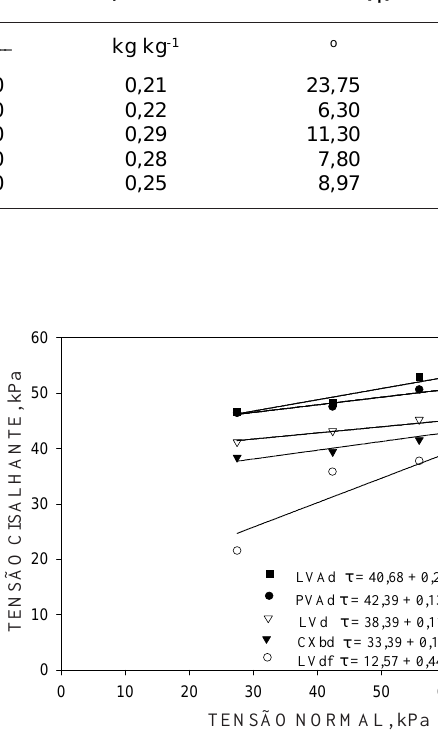
Figura 2. Envoltórias de resistência para os cinco solos